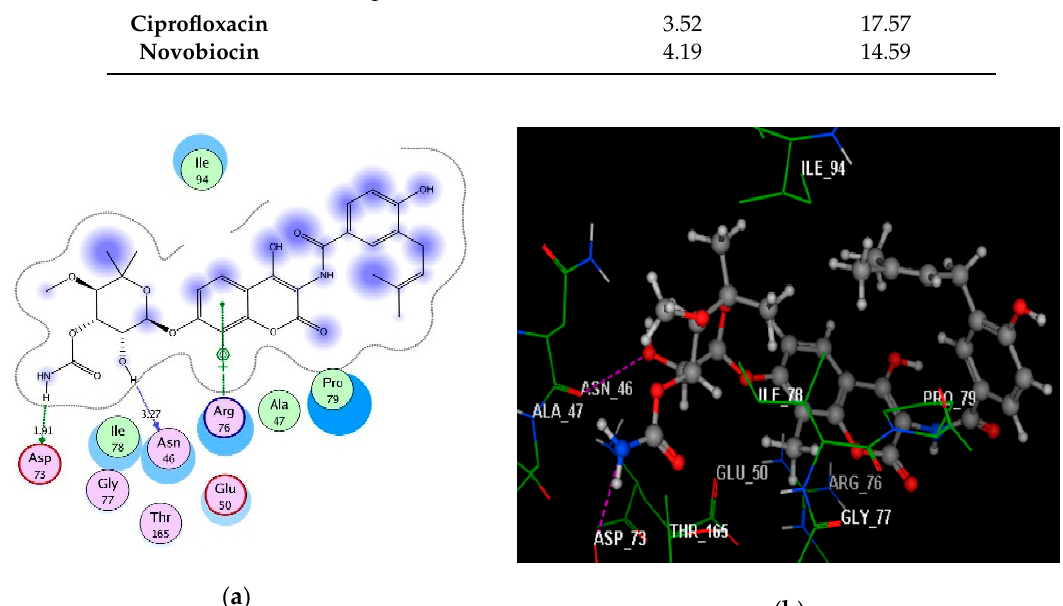
Figure 3. ( a , b ) Diagrams illustrating the 2D and 3D binding patterns of novobiocin onto the ATP-active pocket of E. coli DNA gyrase B kinase (PDB code: 1AJ6),